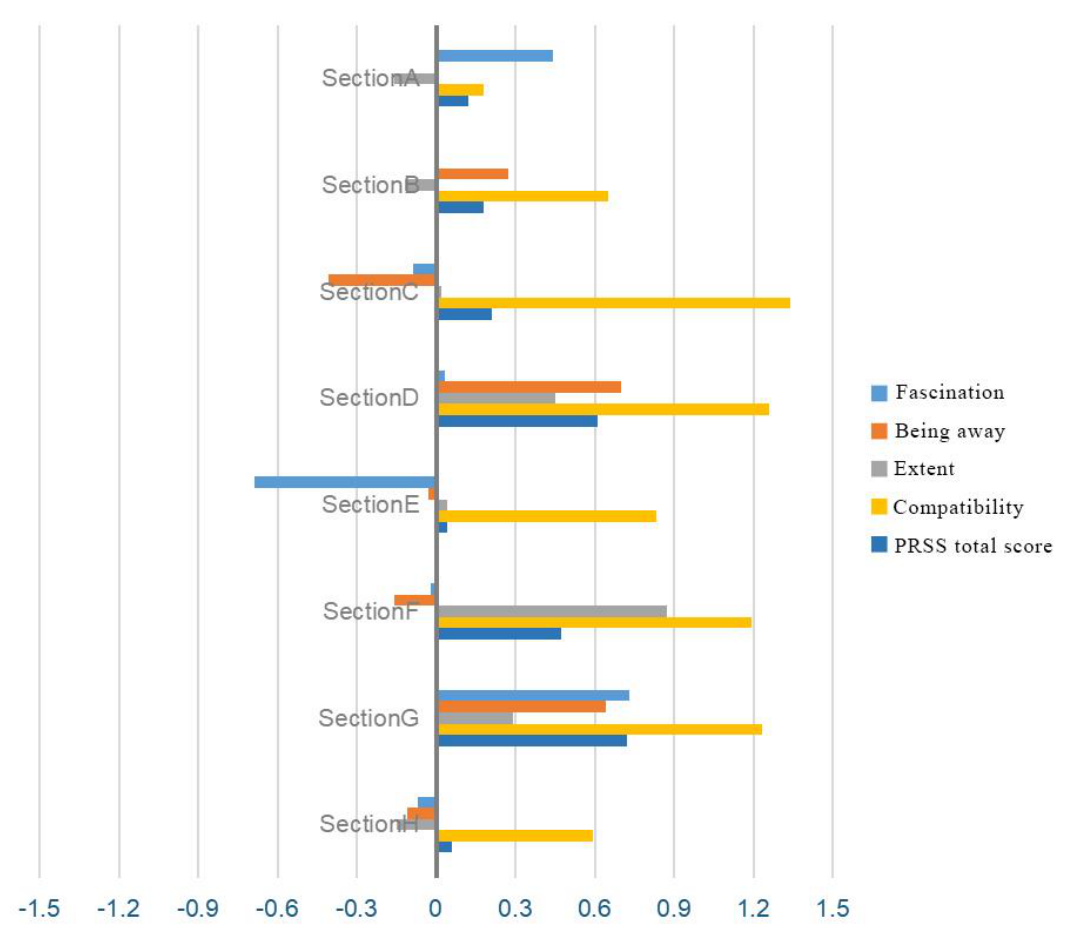
Figure 7. Changes in perceived resilience after introducing birdsongs (PRSS).